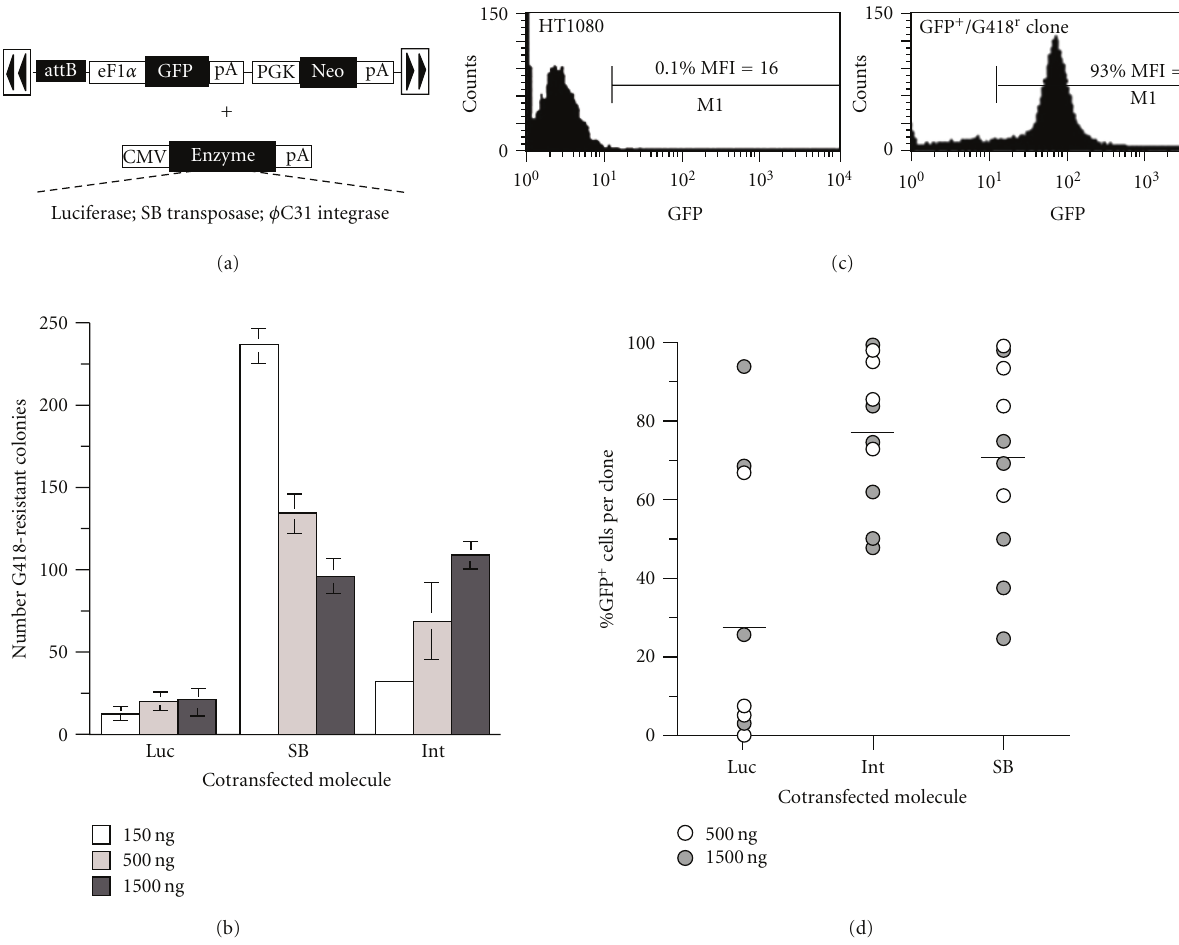
Figure 2: Stable expression mediated by SB transposase and φ C31integrase in cultured human fibroblasts. (a) Schematic diagram of plasmids cotransfected into HT1080 cells in a colony-forming assay. The integrating vector (pKT2/NAG) is described in Figure 1. Recombinase- encoding plasmids are transcriptionally regulated by the cytomegalovirus immediate early promoter (CMV). The firefly luciferase encoding expression vector (Luc) serves as a control for colony formation resulting from random recombination compared to stable gene transfer mediated by SB transposase (SB) or φ C31 integrase (Int). (b) Colony-forming assay for integration e ffi ciency. HT1080 cells (4-5 × 10 5 ) were cotransfected in triplicate with pKT2/NAG (500ng) and 150ng, 500ng, or 1500 ng of Luc, SB, or Int encoding expression plasmids as described in Section 2. The number of G418-resistant colonies per 3 × 10 4 cells plated is shown for each group ( n = 3). Values are reported as mean ± SE. (c) GFP expression in transgenic HT1080 cells. Examples of flow cytometry plots are shown for unmanipulated HT1080 cells (left panel; GFP negative) or an expanded G418-resistant clone (right panel; GFP positive). (d) Percentage GFP-positive cells determined by flow cytometric analysis of 10 independent G418-resistant clones expanded from HT1080 cells cotransfected with pKT2/NAG and 500ng (open circle) or 1500 ng (filled circle) of Luc, SB, or Int expression vectors. Mean percentages of GFP-positive cells for each condition are indicated by solid